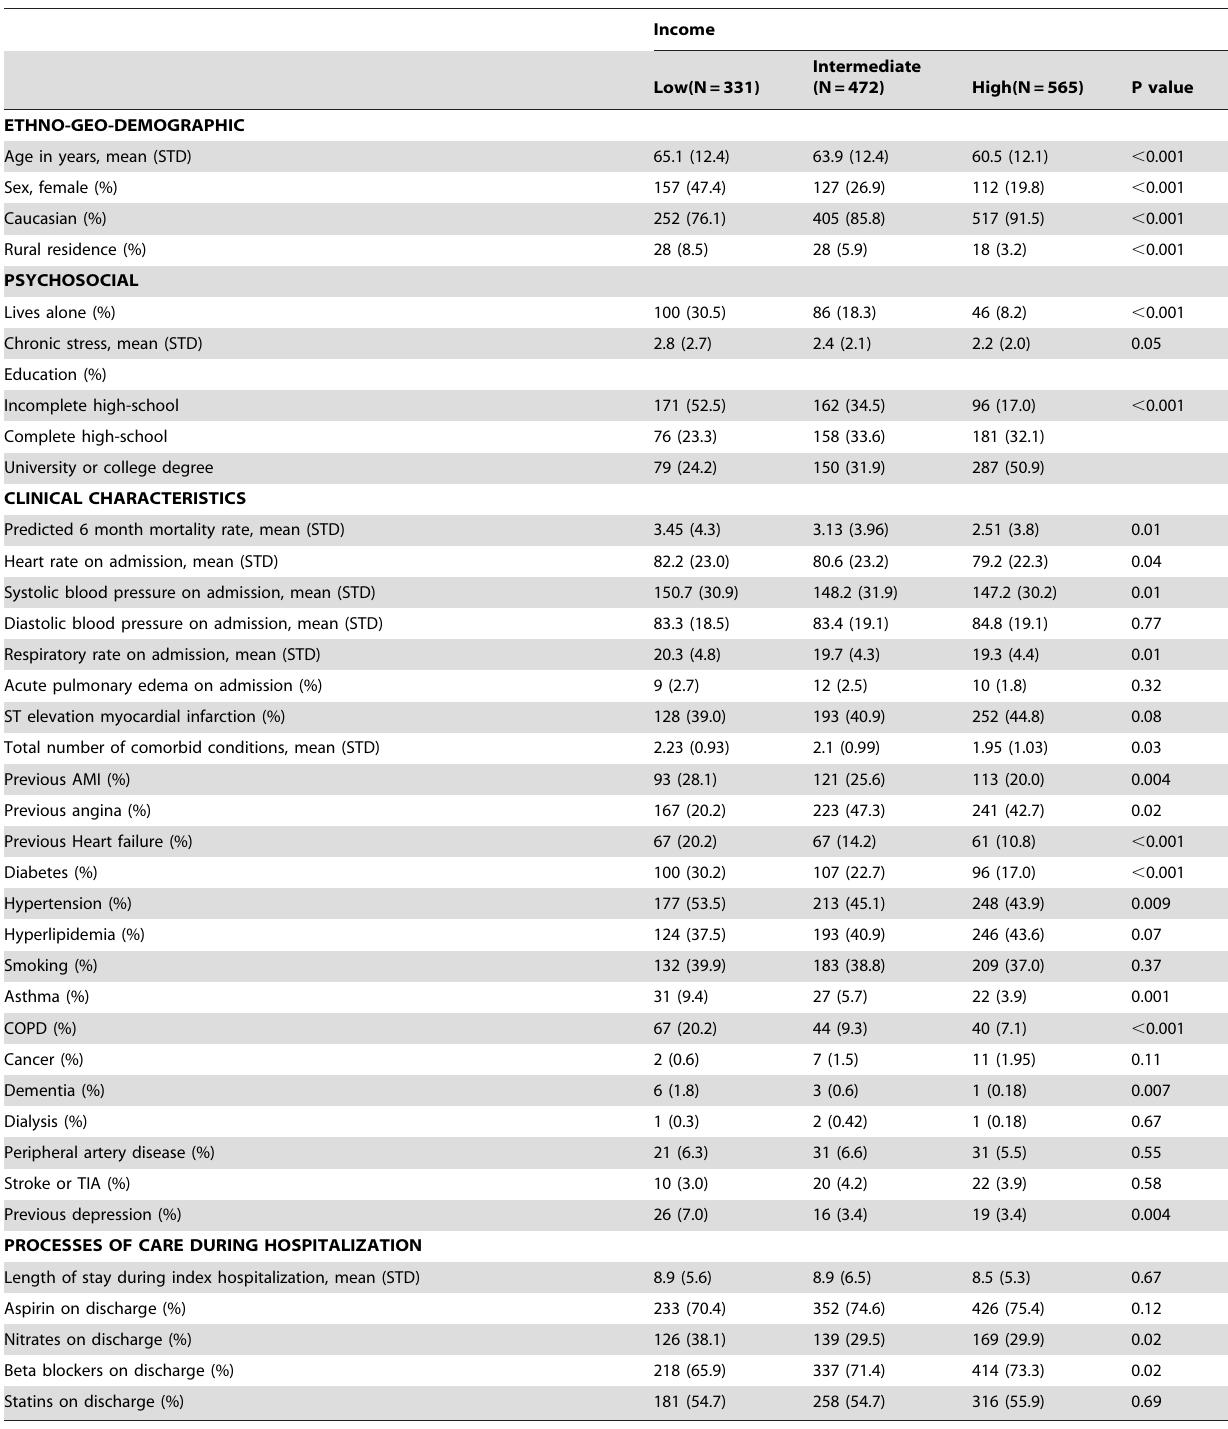
Table 1. Baseline characteristics of study participants according to income